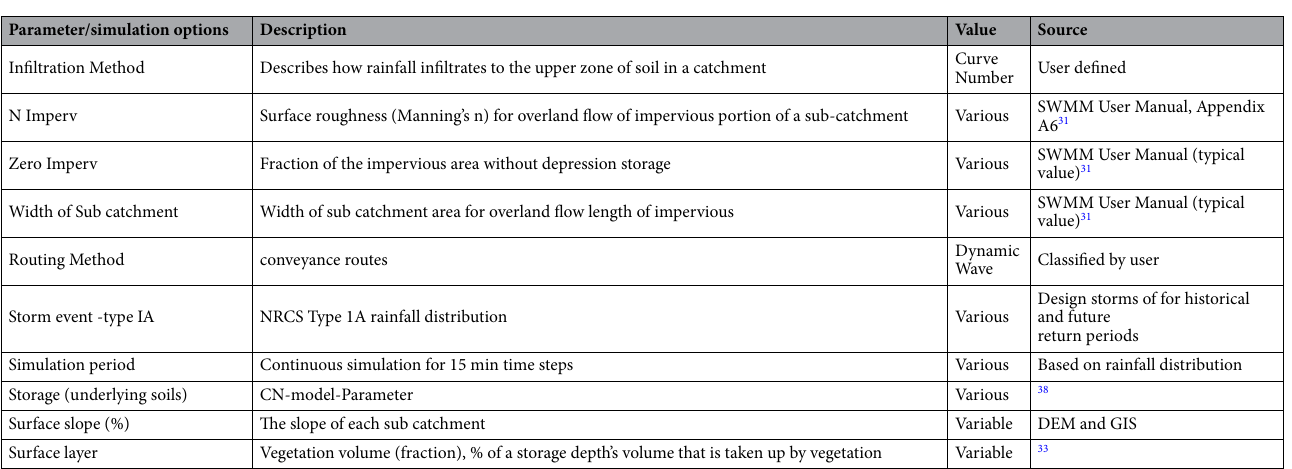
Table 2. List of parameters considered for development of PCSWMM